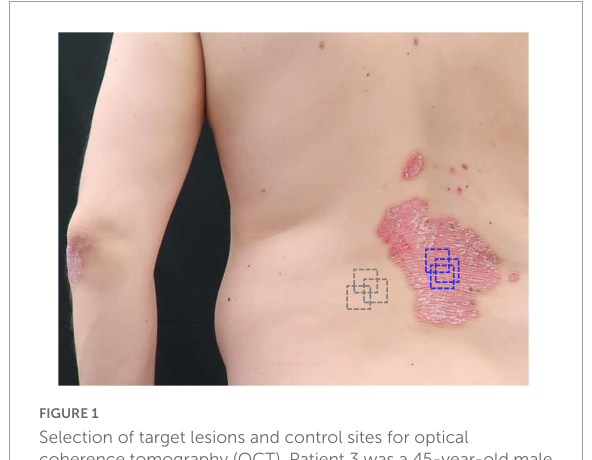
FIGURE1 Selection of target lesions and control sites for optical coherence tomography (OCT). Patient 3 was a 45-year-old male patient with plaque psoriasis showing PASI = 10.8 and BSA = 10% at baseline. A representative target lesion (blue) on his trunk was selected for 52 weeks monitoring. A perilesional location was selected as the control site (gray). The scans were performed repetitively at the same lesional and non-lesional